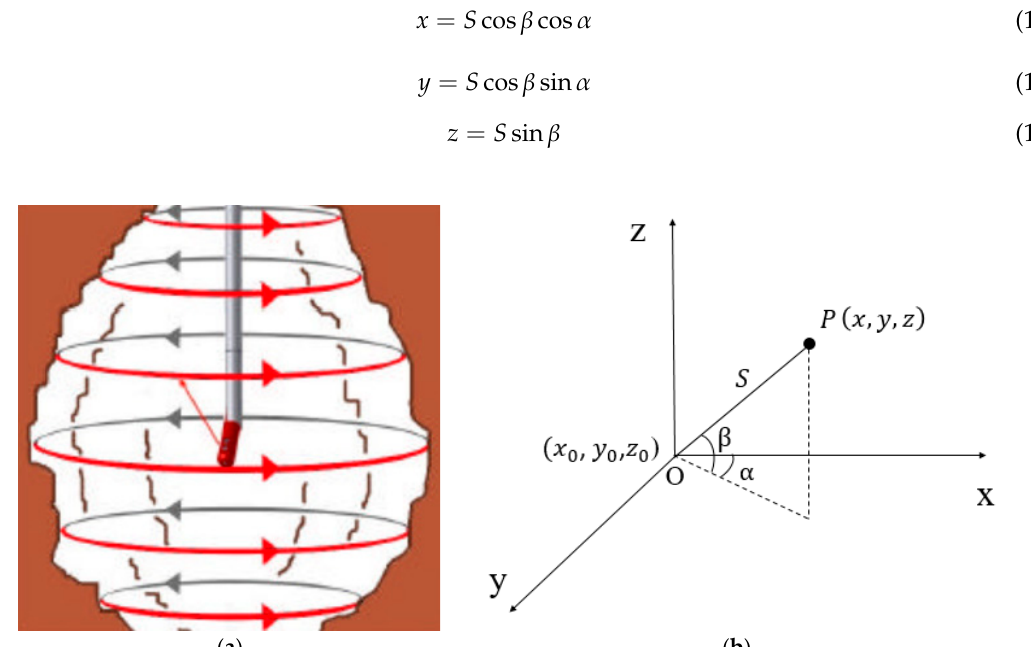
Figure 10. Principles of laser measurement: ( a ) scanning line; ( b ) coordinate calculation of the point cloud.